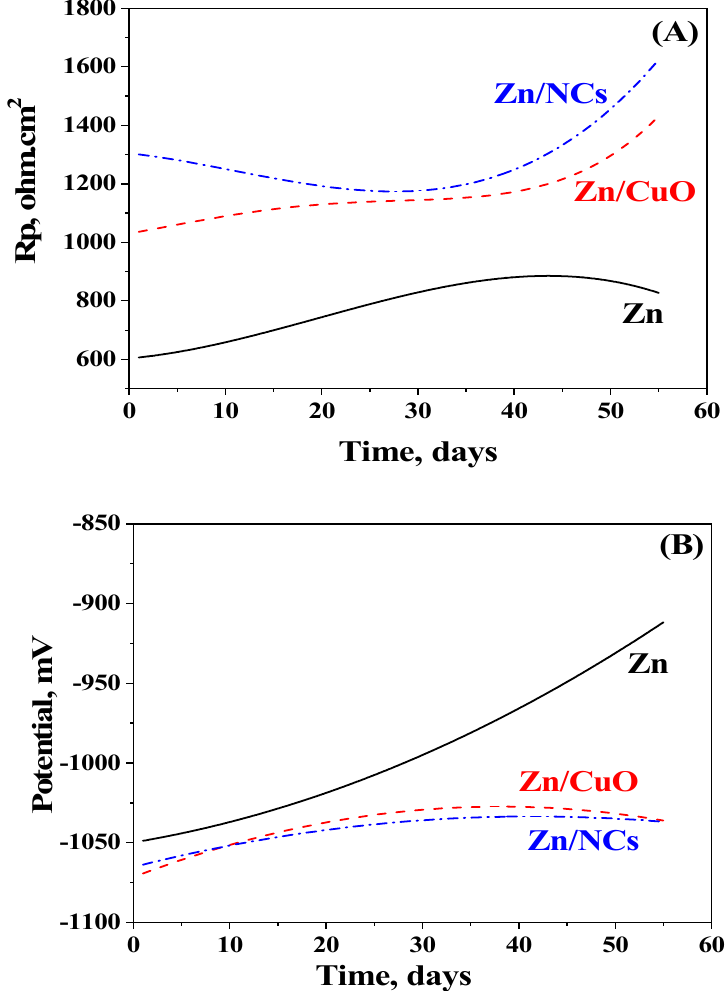
Figure 6. Polarization resistance ( A ) and open-circuit potential ( B ) measurements in a model corrosive medium of 5% NaCl.